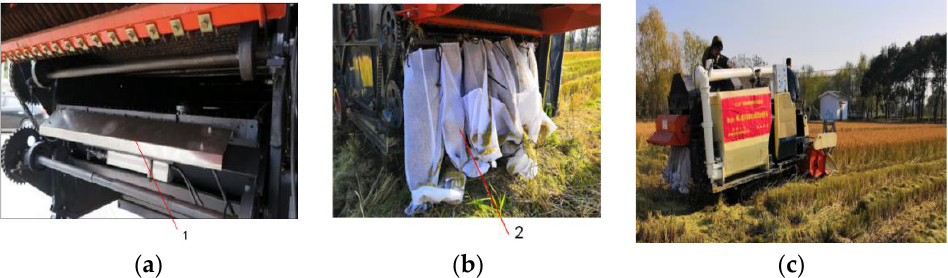
Figure 6. Installation of the grain loss sensor in combine harvesters and field experiment. ( a ) Instal- lation of the grain loss sensor, ( b ) perforated bags ( c ) field experiment. 1 — grain loss sensor, 2 — perforated bags